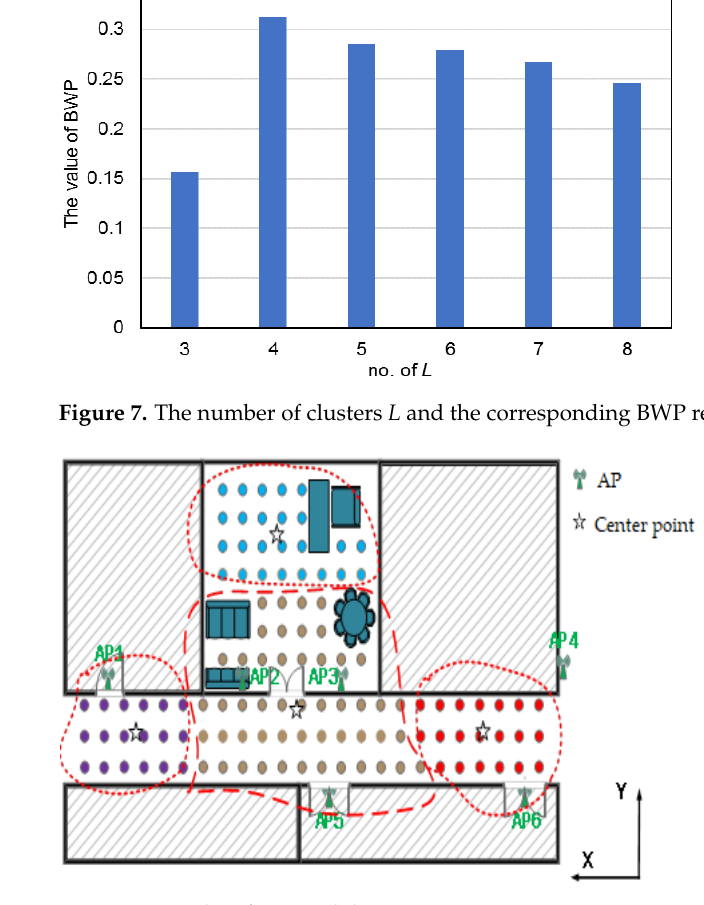
Figure 8. Results of regional division. The five-pointed star icons represent the centre position of each cluster. From right to left, the coordinates of the four centre positions are (2.05, 3.85), (2.86, 13.04), (2.00, 21.50) and (8.28, 14.16).